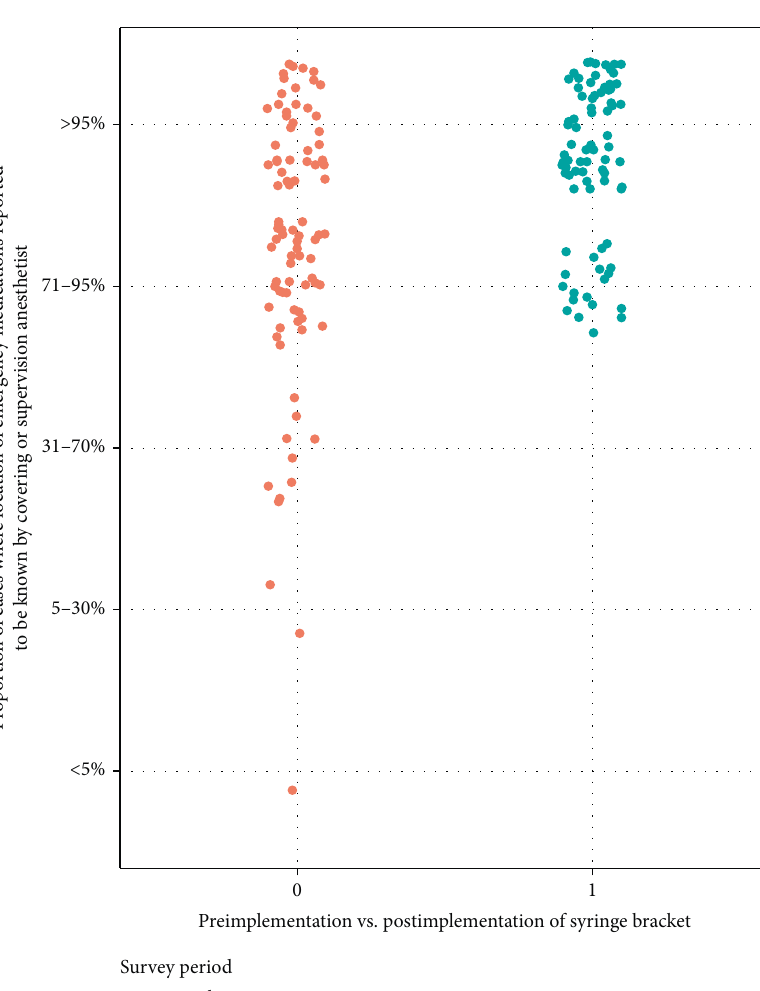
Figure 4: Provider responses to the following question, before versus after hospital-wide deployment of the emergency medication bracket: “In thinking about the last three months, when you have taken over a case from someone else OR are supervising. Another provider, approximately what percentage of the time do you know where the emergency drugs (phenylephrine, ephedrine, propofol, succinylcholine, glycopyrrolate) are located?” Self-reported confidence was increased from a mean of 4.25 to 4.76 on 5-point scale, preimplementation vs postimplementation ( p < 0 .